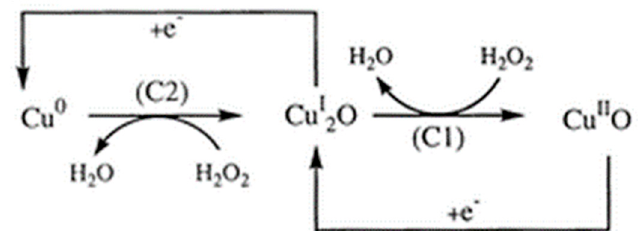
Figure 4. The copper (Cu)-mediated reduction process of H 2 O 2 at the CuSPE (copper-plated screen- printed carbon electrode) [55]. The transition from Cu 0 to the Cu I 2 O ( left ) and Cu I 2 O to the Cu II O ( right ) drives the production of H 2 O from H 2 O 2 with C2 and C1, representing the energy differences at the two cathodes, respectively. Reprinted with permission from ref. [56]. Copyright 2000 Royal Society of Chemistry.